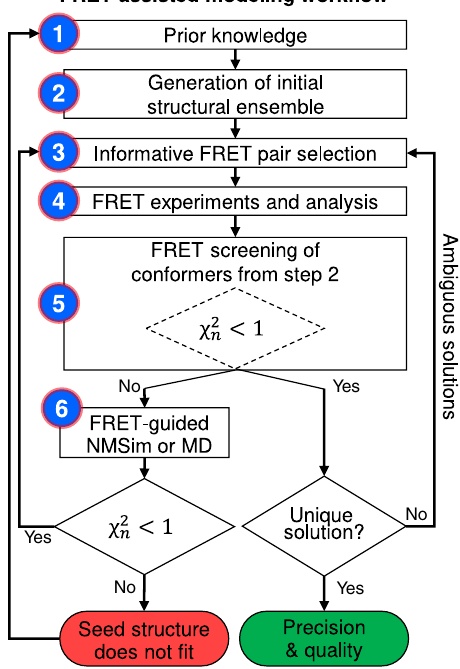
Fig. 1 Iterative work fl ow for automated and optimally FRET-assisted structural modeling. The work fl ow covers cases with (left branch) and without FRET-guided conformer optimization (right branch) and using a χ 2 as a criterion for branching ( “ Methods ” , Eq.